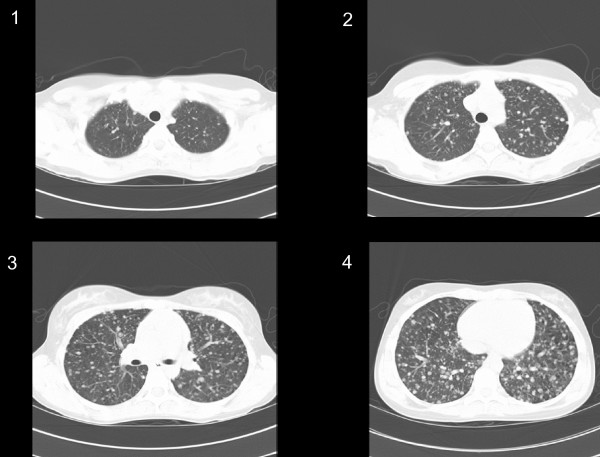
CT scan of the chest that cuts from the apices (1) to the lung bases (4) and shows tremendous tumor burden as well as a basilar prominence of metastases typical of papillary thyroid carcinoma lung metastases.